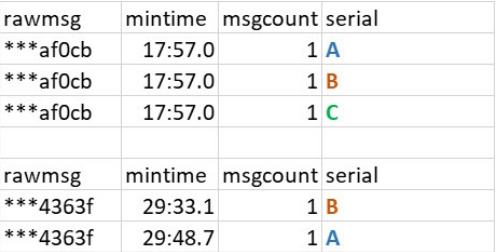
Figure 5. Sample data of receiver with inconsistent internal clock.